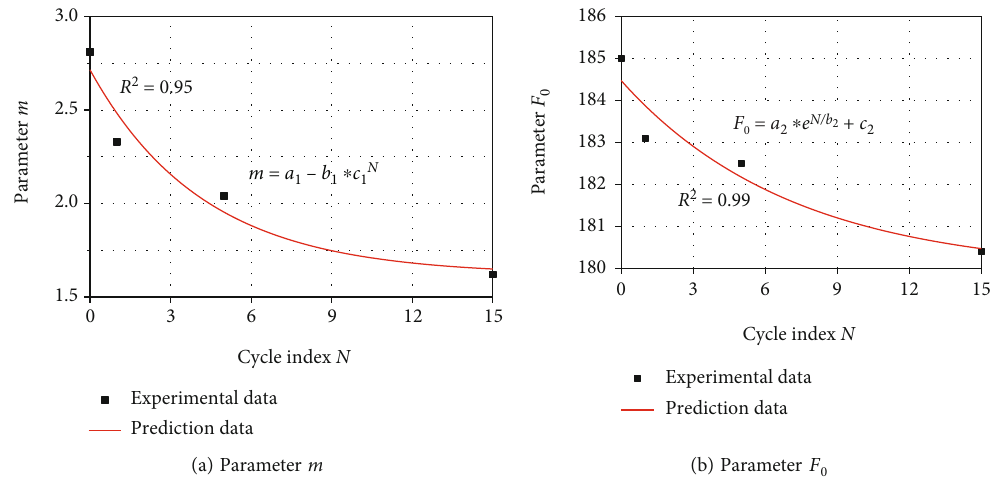
Figure 6: The change of constitutive equation parameters under di ff erent conditions of wetting and drying